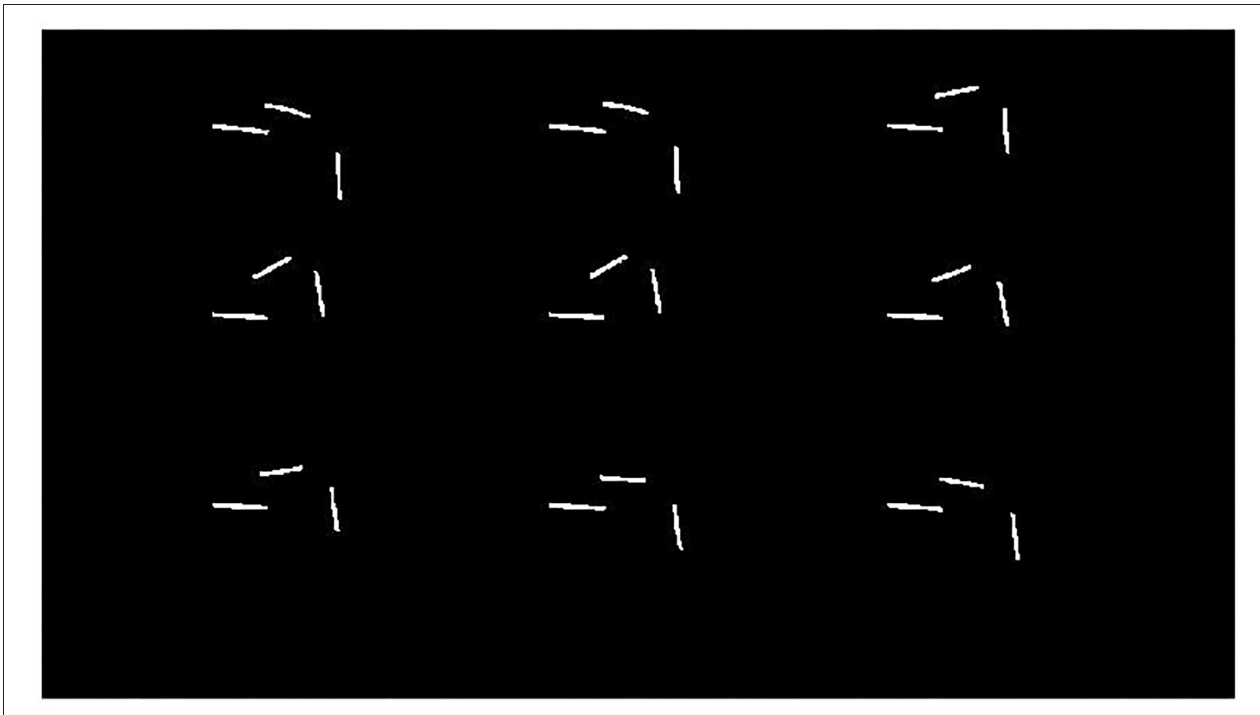
FIGURE 8 | Binary image processed by threshold segmentation.